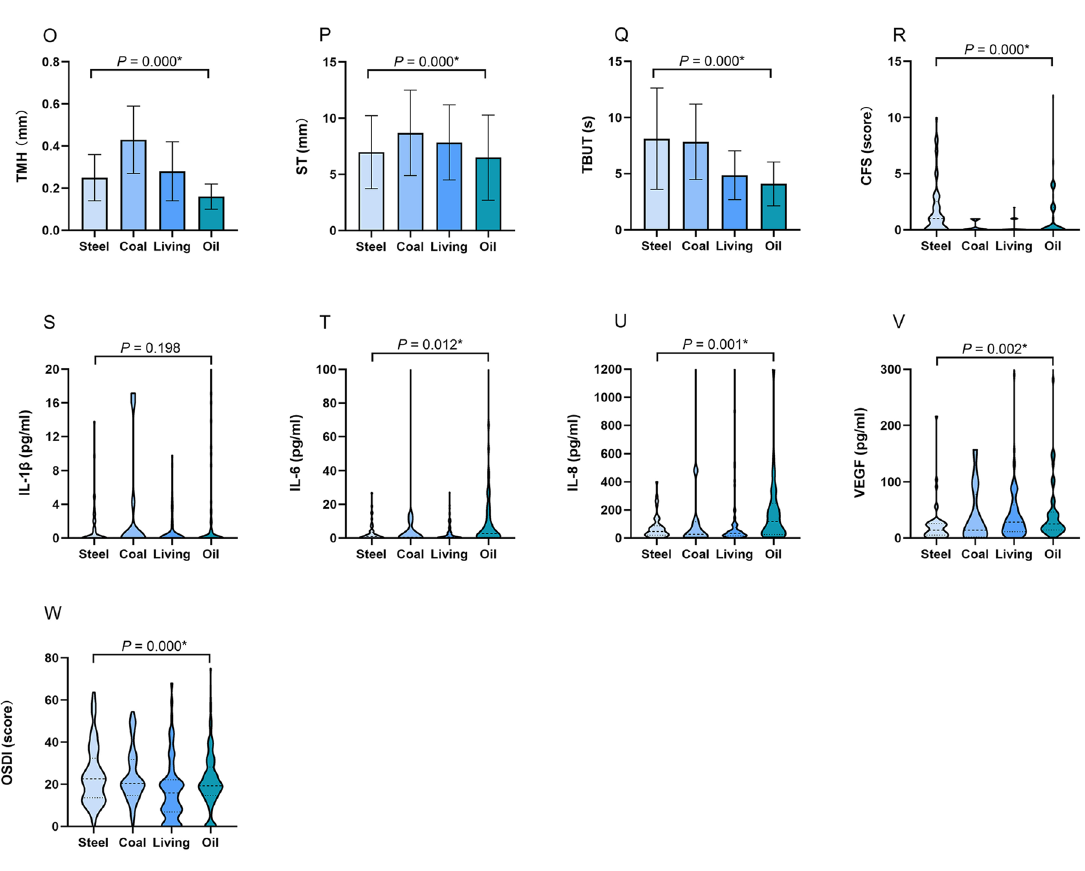
Figure 1. The differences of meteorological factors, ambient pollutants, ocular surface status and cytokine levels in four regions. In oil region, the temperature was significantly lower ( A ), the concentrations of O 3 ( G ) and SO 2 ( I ) were significantly higher than other regions. Relative humidity ( B ), AQI ( D ), PM 2.5 ( E ), and PM 10 ( F ) in coal region were significantly higher than other regions. The wind speed ( C ) in steel and oil region was significantly higher than coal and living regions. NO 2 concentration ( H ) in steel region was significantly lower than other regions. Individuals in living region presented a low proportion of eyelid hyperemia ( J1 ), coal and oil regions exhibited a high proportion of lid debris ( J2 ). Participants in steel region had a relatively high proportion of lid edema ( J3 ) and irregularity ( J4 ). Individuals in oil and steel regions exhibited a high proportion of eyelid neovascularization ( J5 ). Participants in oil region had a high incidence of MG plugging ( K1 ), but few suffered from MG stenosis ( K2 ). Individuals in oil region mainly exhibited higher levels of MG expression ( M1 ), MG secretion ( M2 ), MG loss ( M3 ), and conjunctivochalasis ( N ) than other regions. Individuals in oil region demonstrated significantly lower TMH ( O ) and ST ( P ), shorter TBUT ( Q ), and higher CFS score ( R ), IL-6 ( T ), IL-8 ( U ), VEGF ( V ). Participants in living region reported less OSDI than other regions ( W ). The results were expressed as median with interquartile range in ( A – I ), ( M , N ) and ( R – W ); as percentage in ( J – K ); as mean ± standard deviation (SD) in ( O – Q ). AQI air quality index, PM particulate matter, O 3 ozone, NO 2 nitrogen dioxide, SO 2 sulfur dioxide, TMH tear meniscus height, ST Schirmer’s I test, TBUT tear film break-up time, CFS corneal fluorescein staining, IL-1β interleukin 1 beta, IL-6 interleukin 6, IL-8 interleukin 8, VEGF vascular endothelial growth factor, OSDI ocular surface disease index, * P <